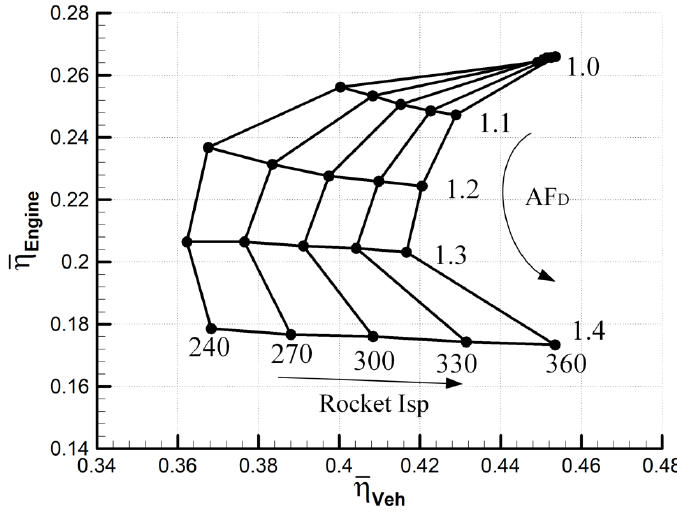
Figure 15. Effect of rocket Isp and vehicle drag on 𝜂̅ 𝒆𝒏𝒈𝒊𝒏𝒆 and 𝜂̅ 𝒗𝒆𝒉 . Figure 15. E ff ect of rocket Isp and vehicle drag on η